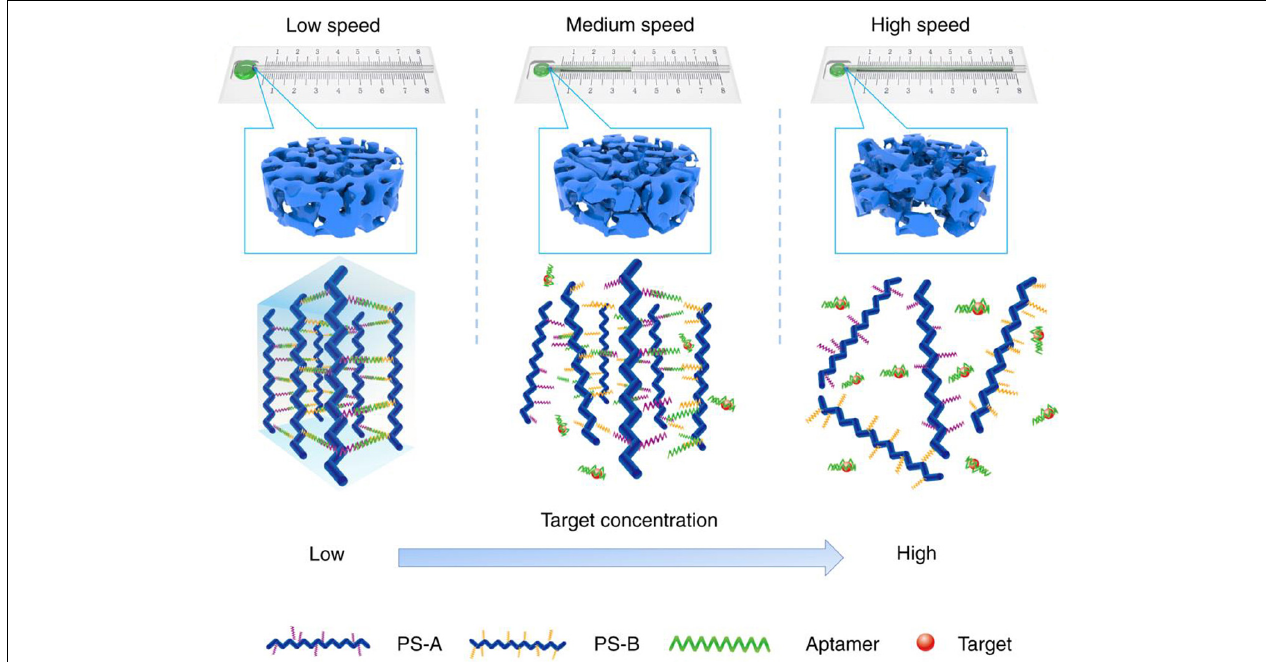
FIGURE 7 | Schematic diagram of the working principle of the DNA-based hydrogel capillary self-driven regulator sensor. Reprinted under the terms and conditions of the Creative Commons CC BY License (Li F. et al., 2019). Copyright 2019, the authors, published by Springer